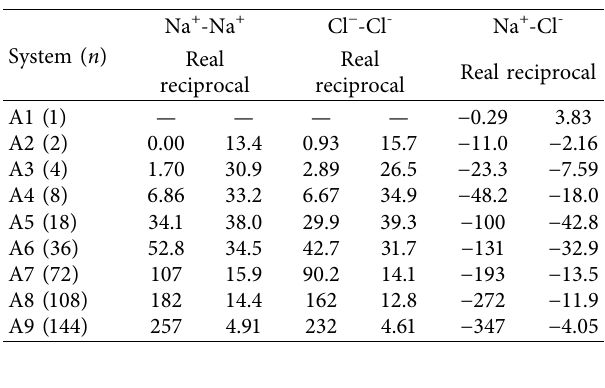
Table 7: The average electrostatic energies (kJ/mol) per ion of the electrolyte systems using Ewald sum with κ � 0.10 ˚A − 1 employing a velocity Verlet algorithm, where n is the number of (Na + or Cl − )